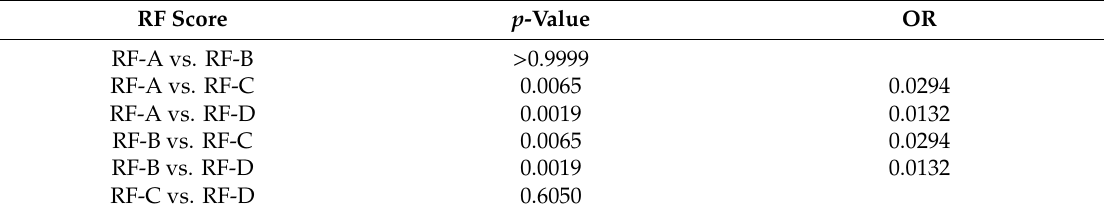
Table 4. Reflective functioning: Comparing RF scores among the four groups (A–B). RF Score p -Value OR RF-A vs. RF-B >